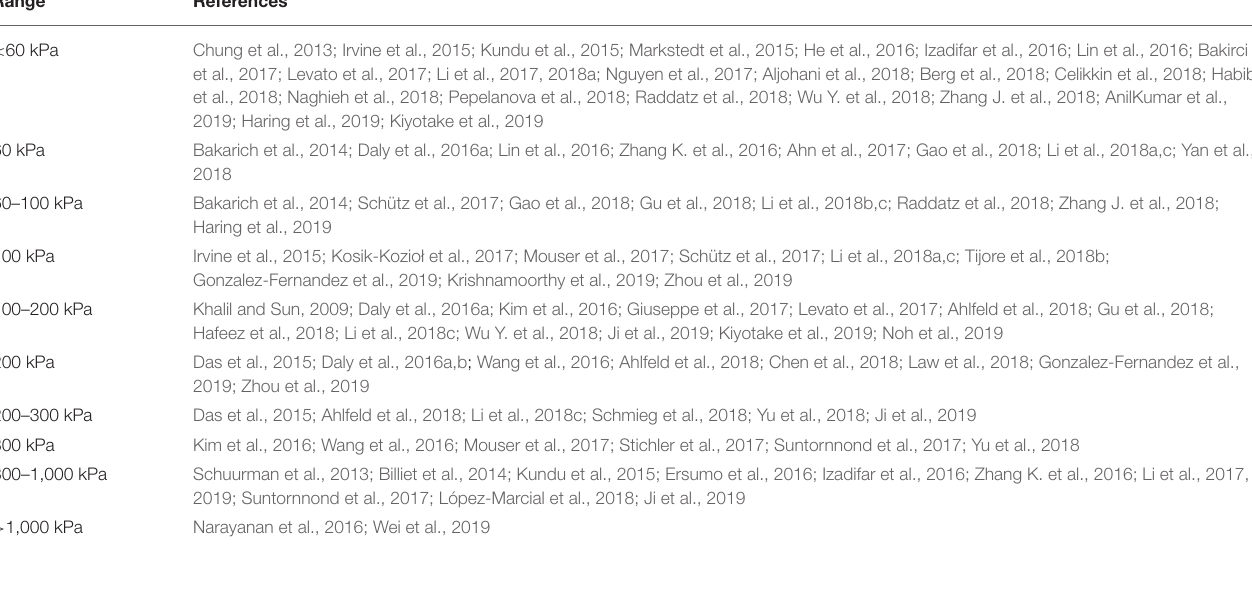
TABLE 2 | Pressure ranges for all papers that studied this setting